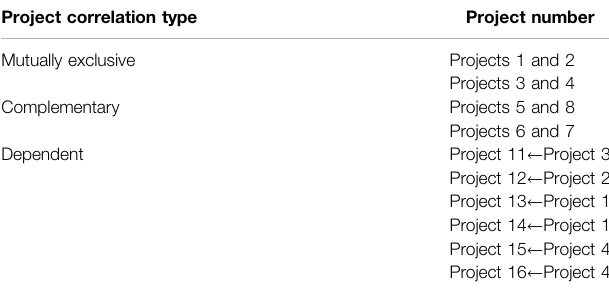
TABLE 6 | Statistics of project time series correlation